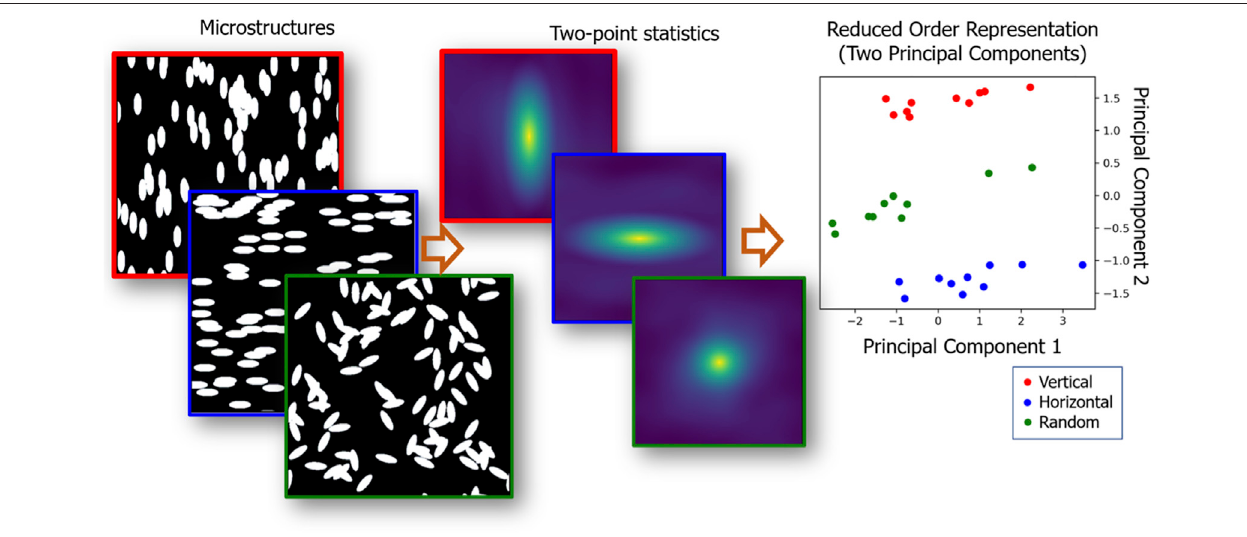
FIGURE 4 | The MKS work fl ow for feature engineering of material structure. In this example, we start with microstructures belonging to three distinct classes (correspondingtovertical,horizontal,orrandomellipses),withoneexampleofeachclassshownontheleft.Theircorresponding2-pointfeaturesareshowninthemiddle and re fl ect a large number of statistics (including volume fractions, size and shape distributions) for each microstructure. The low-dimensional representations of the microstructure statistics are shown on the right, in the subspace of the fi rst two PC scores. The clusters in the PC plots successfully classify the microstructures in the three classes. The intra-class variance between microstructures within each class can also be quanti fi ed from the PC representations.